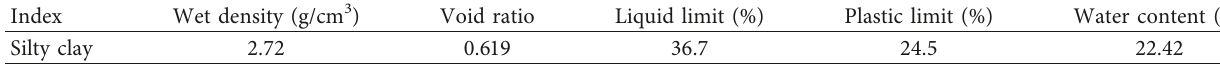
Table 1: Physical and mechanical indexes of the soils of silty